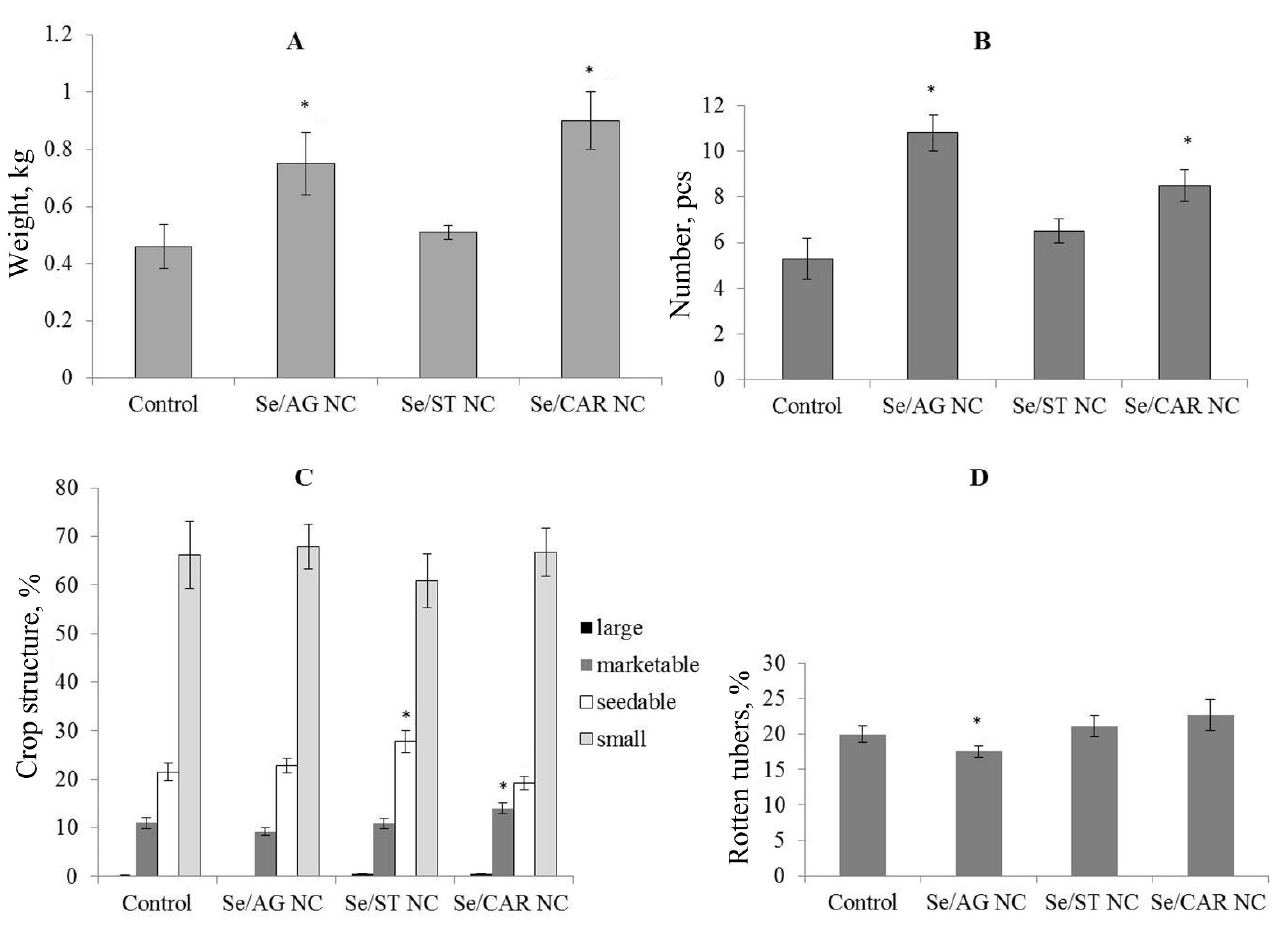
Figure 3. Effect of treatment of potato tubers with selenium (Se) nanocomposites (NCs) on the weight of tubers ( A ) obtained from the first-generation plants grown from treated tubers, their number; ( B ), crop structure—proportion of large, marketable, seedable and small tubers; ( C ) percentage of rotten tubers; ( D ) in the first generation; * Significant differences from control, p < 0.05 based on Mann–Whitney U test. Se/AG NC, Se/ST NC and Se/CAR NC are arabinogalactan-, starch- and kappa-carrageenan-based Se nanocomposites.